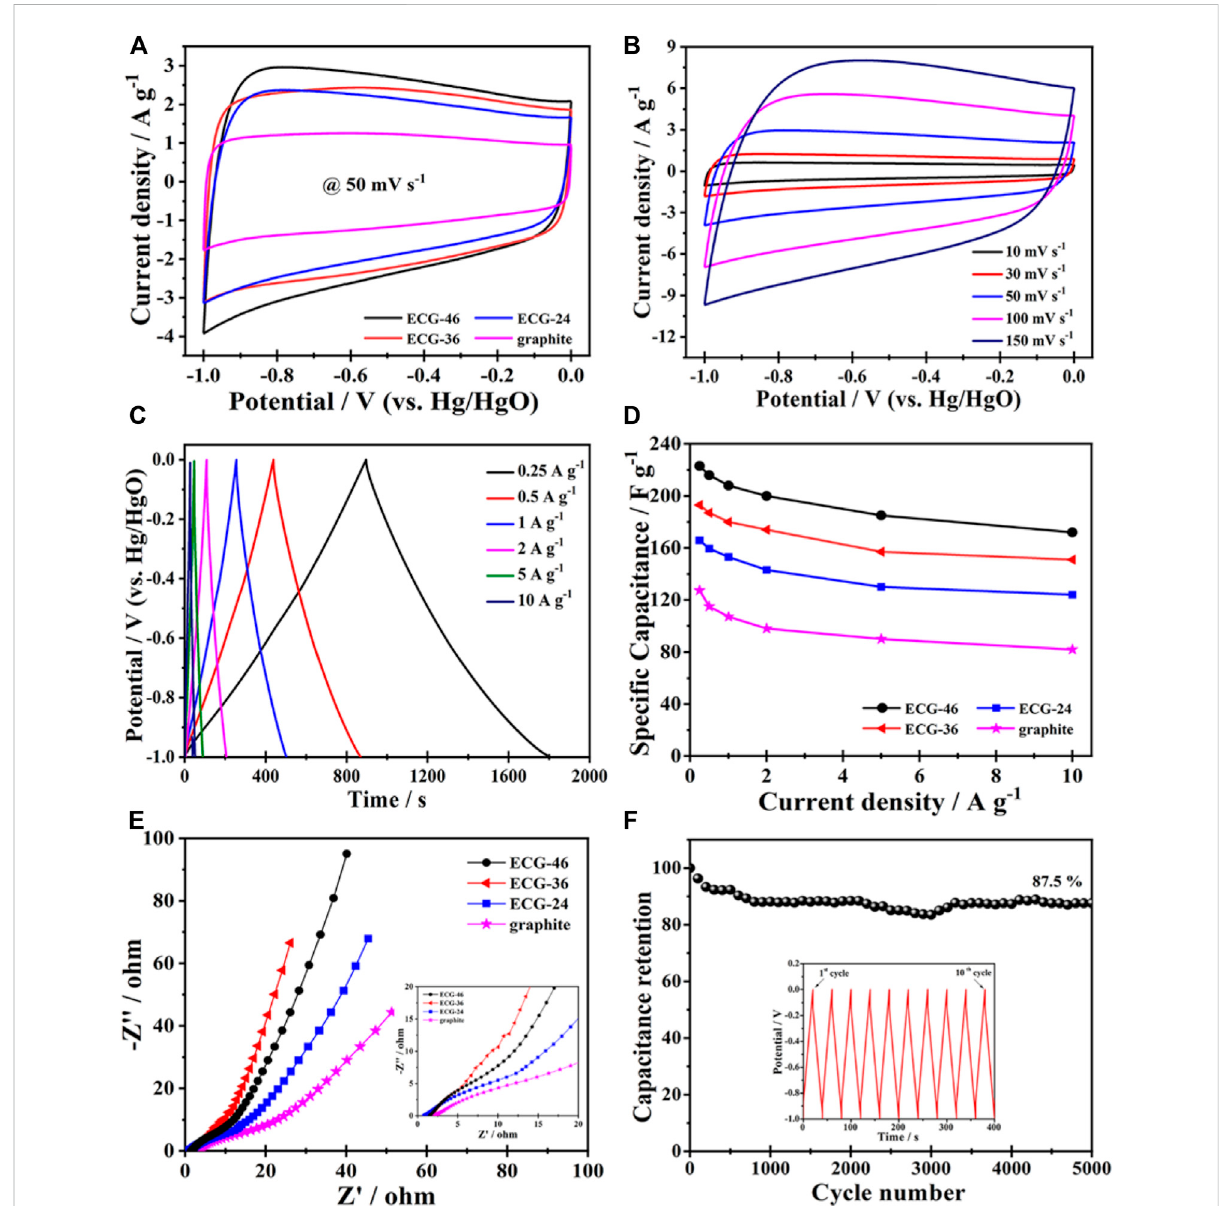
FIGURE 5 The CV curves of (A) ECG-46, ECG-36, ECG-24 and graphite at 50 mV s − 1 and (B) ECG-46 with respect to scanning rate; (C) The GCD curves withrespectto current densities ofEGC-46; (D) The speci fi ccapacitancesofEGC-46, EGC-36,EGC-24 andpristine graphite; (E) Nyquistplotofthe ECG-46, ECG-36, ECG-24 and graphite electrodes; (F) the cycling stability of the ECG-46 in 2 M KOH electrolyte (Inset presents the GCD curves of 1st to 10th